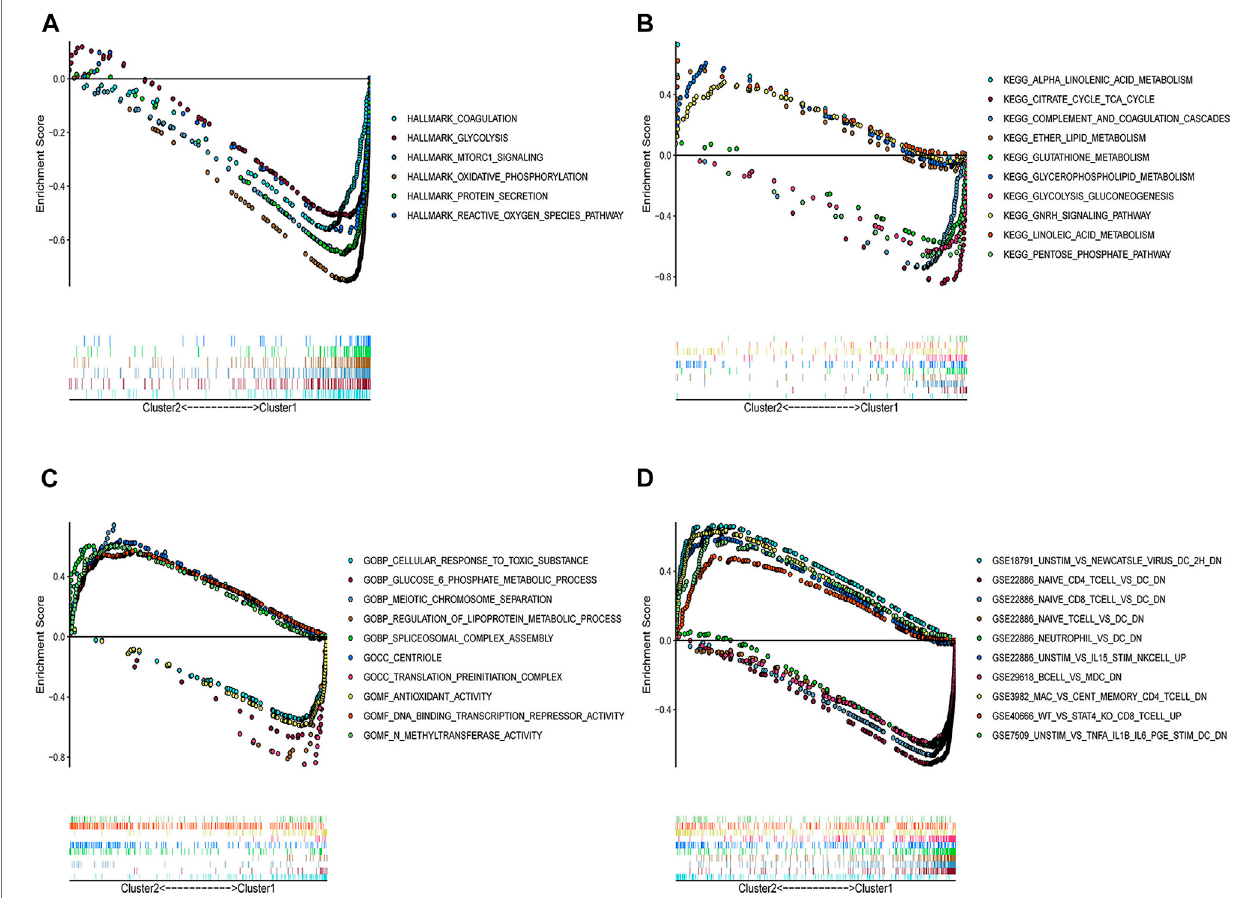
FIGURE 3 | GSEA for the two clusters. (A) Tumor hallmarks were enriched in cluster 1. Multi-GSEA enrichment curves for the (B) C2 KEGG collection, (C) C5 GO collection, and (D) C7 collection for two clusters. All the | NES | > 1, Nominal p < 0.05, and false discovery rate-corrected q < 0.25. NES: Normalized enrichment